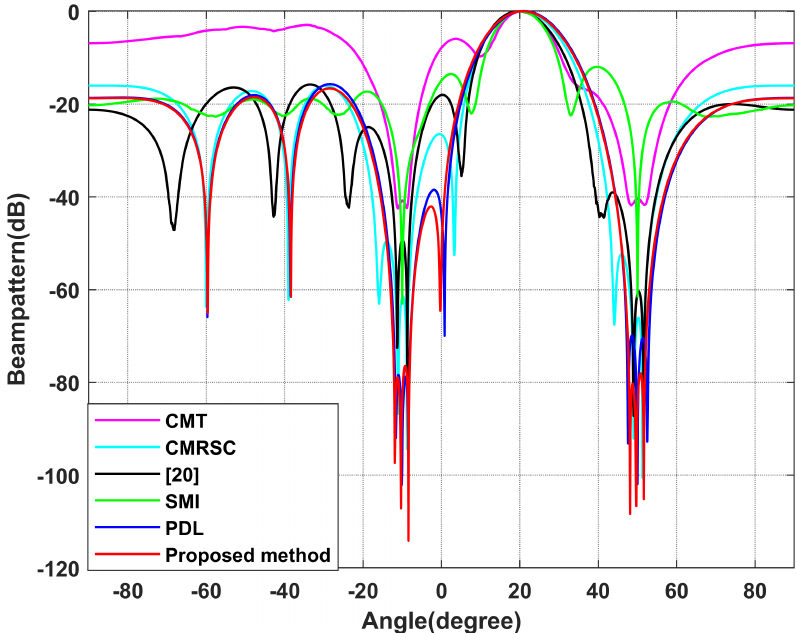
Figure 9. Beamforming diagram. Simulation